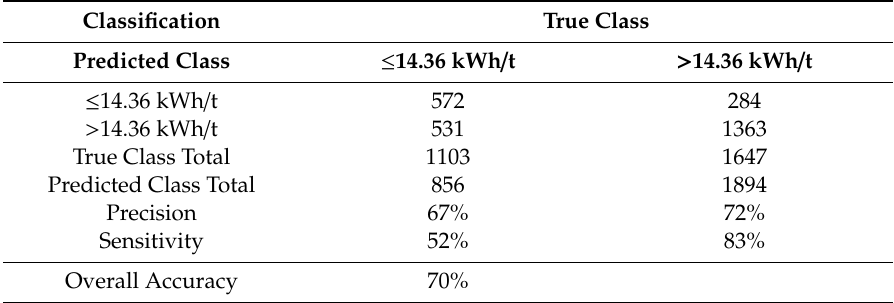
Table 3. Confusion matrix, after 10-fold cross-validation (CV), of the random forest (RF) model for BWI classification.